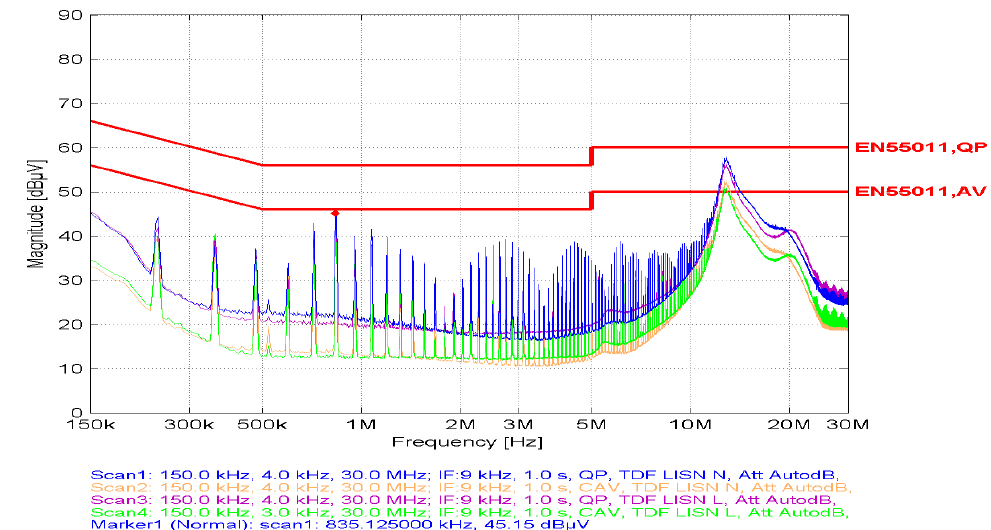
Figure 14. Attenuation level for ferrite No. 2 with the number of coils at 28